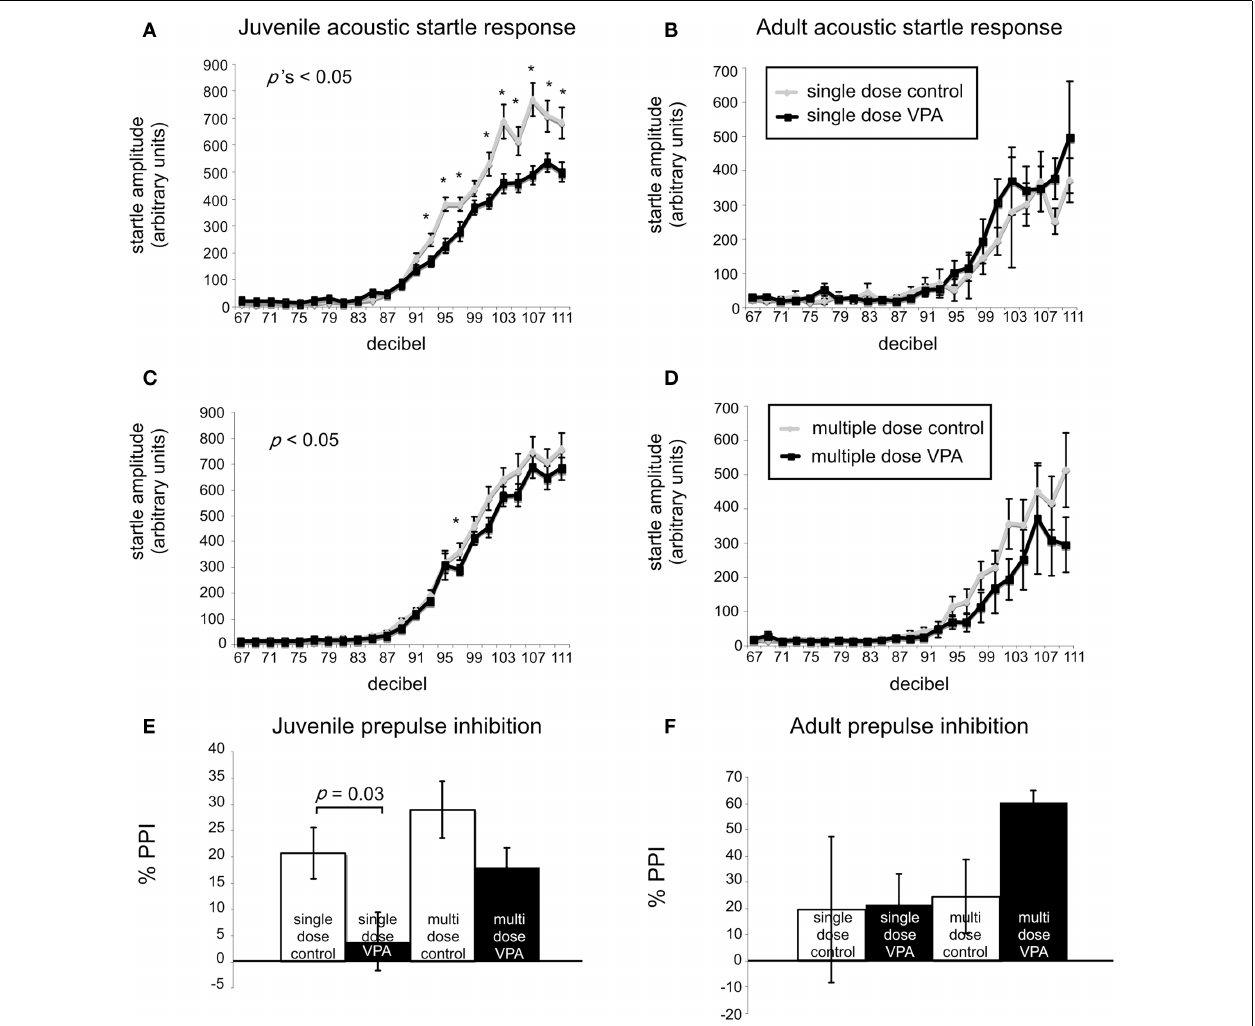
treated with multiple doses ofVPA show no difference from controls. (E,F) . Juvenile and adult prepulse inhibition. (E) Juvenile rats treated with a single dose ofVPA show decreased prepulse inhibition. (F) This is reversed in adult rats. Juvenile and adult rats treated with multiple doses ofVPA respond similarly to